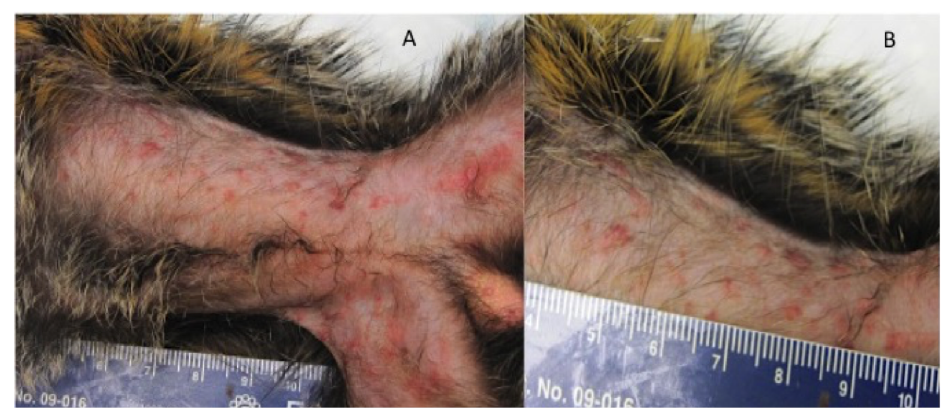
Fig 6. Skin of a mock treated marmoset exhibiting a classical smallpox rash. Previous to exposure with 1000 PFU of monkeypox virus, animal 5 was treated with non-pox-virus specific antibody. This animal manifested a typical smallpox rash as can be seen on the exposed (hairless) portions of the abdomen and groin (A) a zoomed in portion of the abdomen is shown in B.